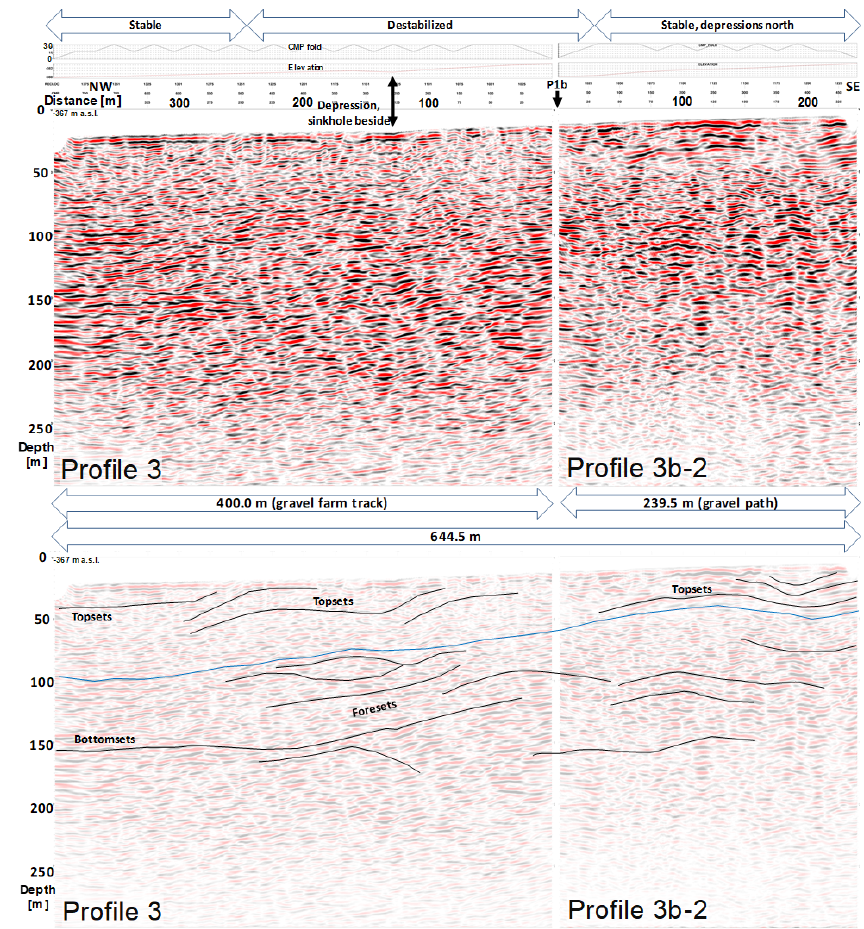
Figure 10. Combined depth sections of profiles 3 and 3b-2 after post stack FD time migration (a) and interpretation of the main structure elements (b) . For annotations, see Fig. 8. The interpreted top of the silt and clay layer in BH1 and BH2 is shown by the blue line. The centre part of the profiling track was repeatedly affected by recent sinkhole activity directly beside it to the northeast. For farming access, it was refilled with gravel along more than 250m and was subsequently again affected by sinkholes and subsidence. This may cause the weaker reflection signatures in the upper 50m when compared to profile 2 (Fig. 8). The main reflection pattern signature is similar to profile 2 and 2b-2, showing northwest-dipping events. In the southeast of the profile, a v-shaped structure is visible close to surface, filled with nearly horizontal reflection events, which is interpreted as a refilled channel side cut. Due to the wide subsidence area northeast of profile 3 the top of the silt and clay layer (blue line) was continued to the northwest starting from profile 1b instead using the projection of